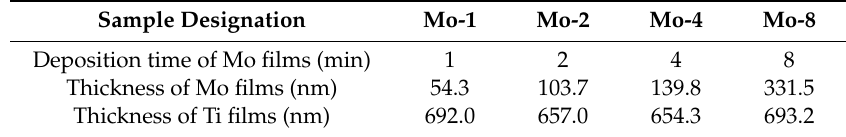
Table 1. Sample designations of Si / Mo / Ti multilayer films with di ff erent Mo deposition times and thicknesses of Mo and Ti films measured by scanning electron microscopy